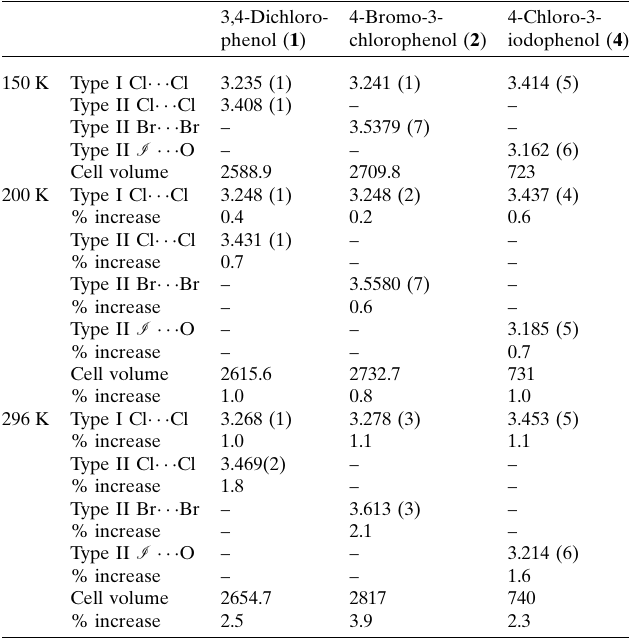
Table 2 Variable temperature study of ( 1 ), ( 2 ) and ( 4 ). All percent increases are with respect to the values at 150 K. 3,4-Dichloro- phenol ( 1